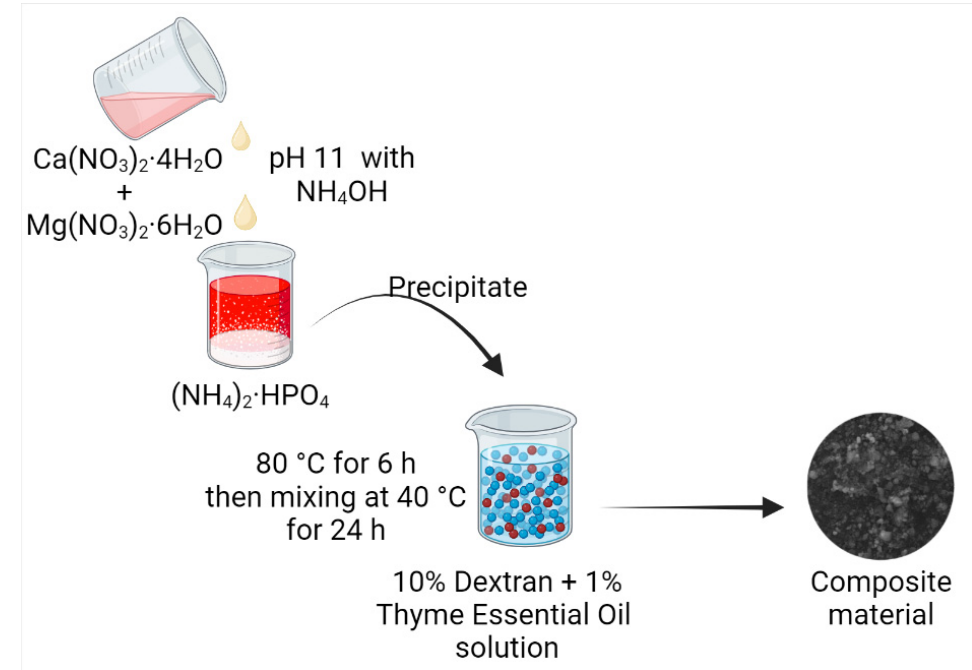
Figure 4. Preparation of antimicrobial coatings with dextran, thyme essential oil, magnesium salt, and hydroxyapatite, as suggested by Iconaru et al. [67].